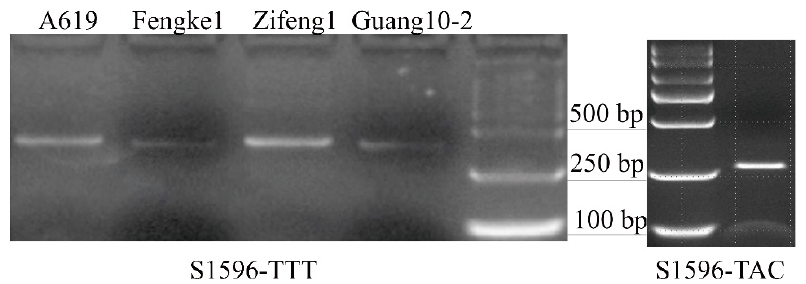
Figure 5. Gel electrophoresis of the CAPS marker variants of the Rf4 gene in maize lines.